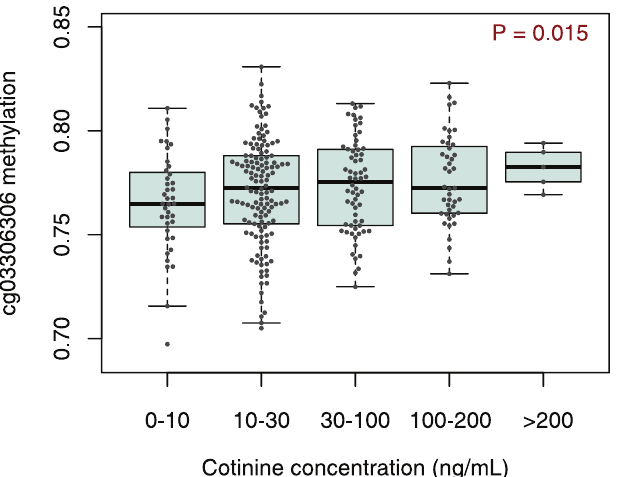
Fig 6. DNA methylation association with smoking exposure. DNA methylation at cg03306306 in nasal epithelial cells at age 11 are plotted against urine cotinine levels from URECA at ages 8–10 as measured using the NicAlert assay (n = 285). URECA, Urban Environment and Childhood Asthma